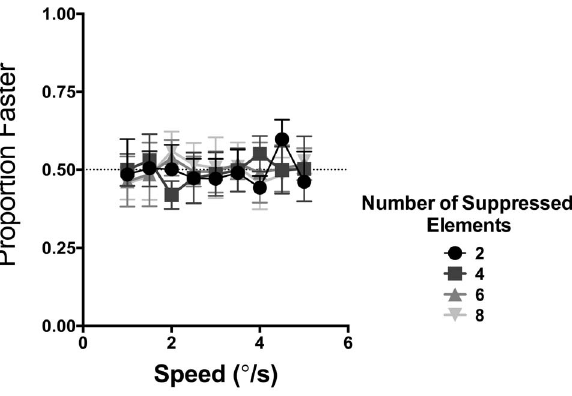
Fig. 4. The ability to judge the speed of suppressed elements. The proportion of times in which observers were able to correctly identify the faster moving stimulus comprising of a number of different elements (different symbols) suppressed from awareness plotted as a function of their speed. Error bars signify 95% confidence intervals.